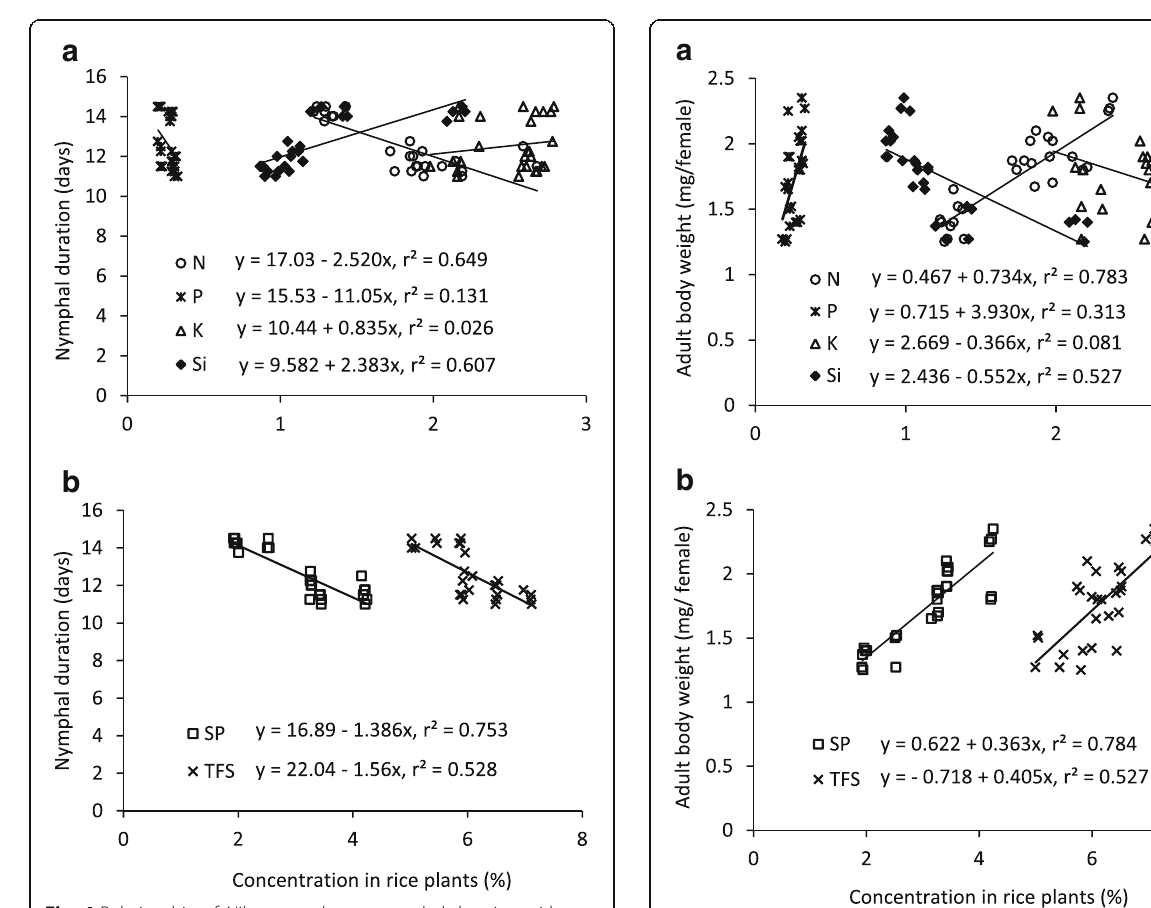
Fig. 4 Relationship of Nilaparvata lugens nymphal duration with plant tissue nutrient concentration. a nitrogen (N), phosphorus (P), potassium (K), and silicon (Si), b soluble protein (SP), and total free sugar (TFS) content in rice plant ( n = 27)